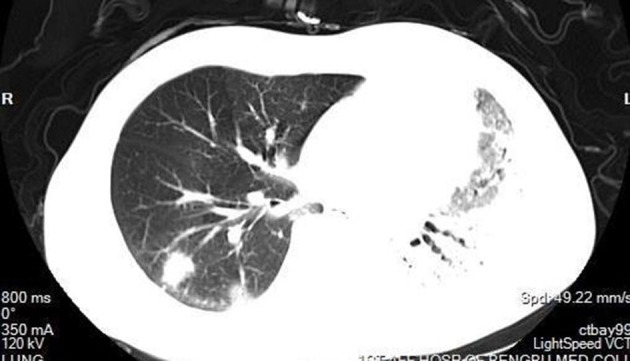
Large area consolidation of both lungs with pulmonary interstitial changes.